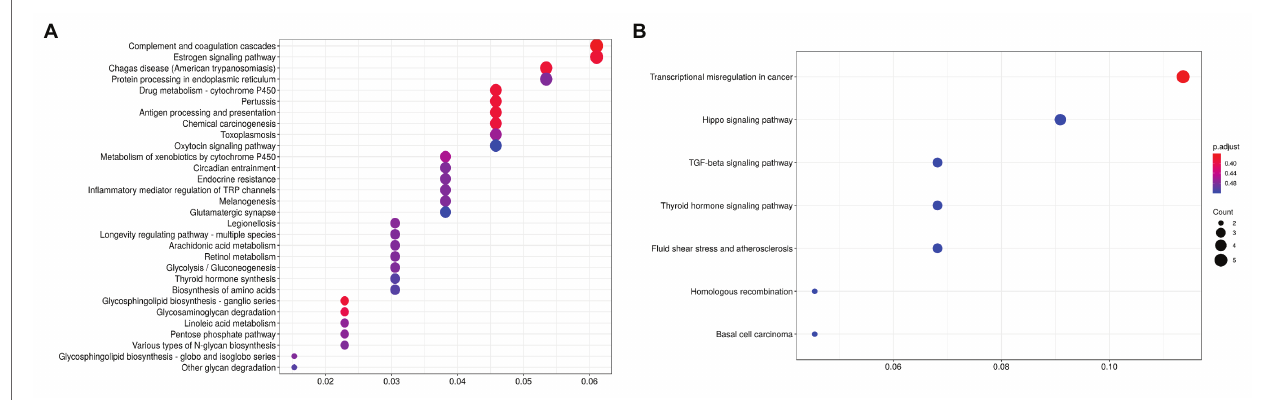
FIGURE 2 | Dotplot showing the results of KEGG pathways enrichment analyses performed for top-250 upregulated (A) and downregulated (B) genes associated with PFS in CRPC. The x -axis indicates k/n ratio (“gene ratio”), where k is the number of genes participating in the current KEGG pathway in the top-250 list and n is the total number of genes that participate this pathway. Dot color indicates the FDR values according to the Fisher’s exact test.